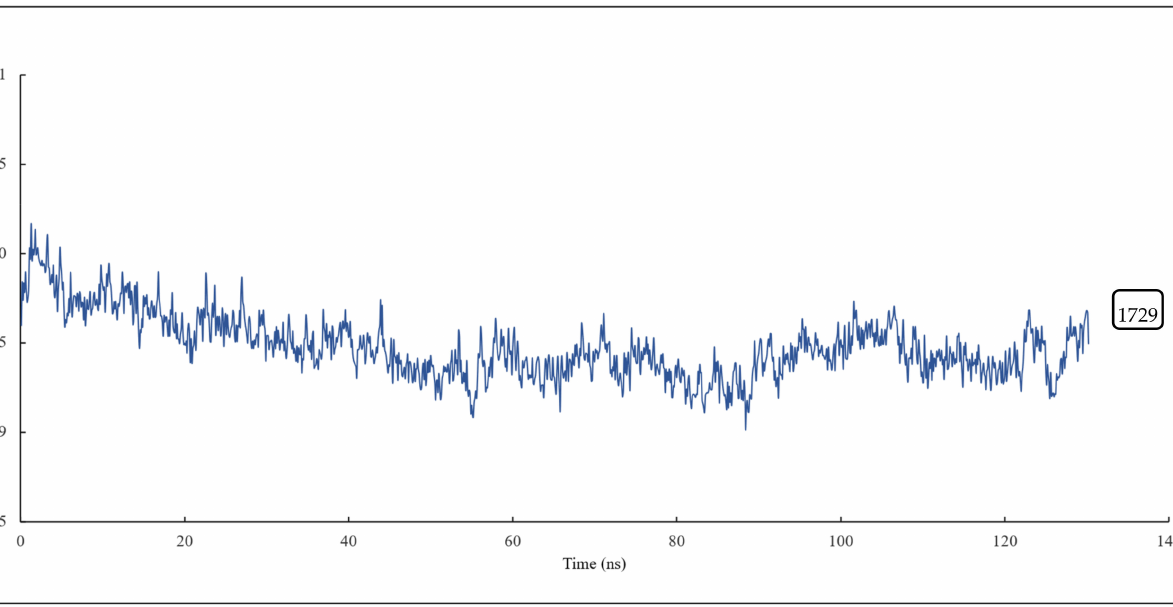
Figure 14. The radius of gyration of all residues and scoulerine in the laulimalide binding